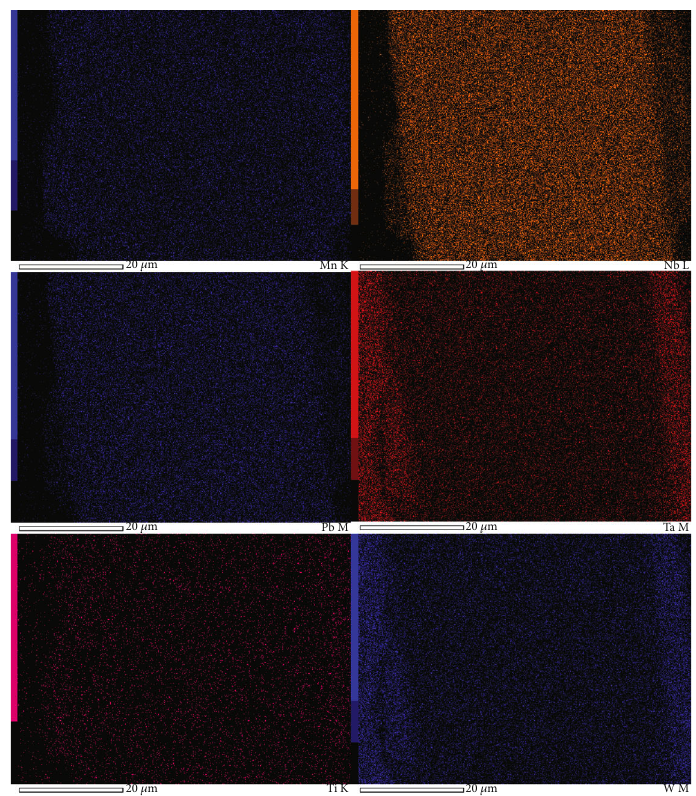
Figure 5: SEM mapping image of the columbite-tantalite mineral grain, indicating homogeneously distributed elements.